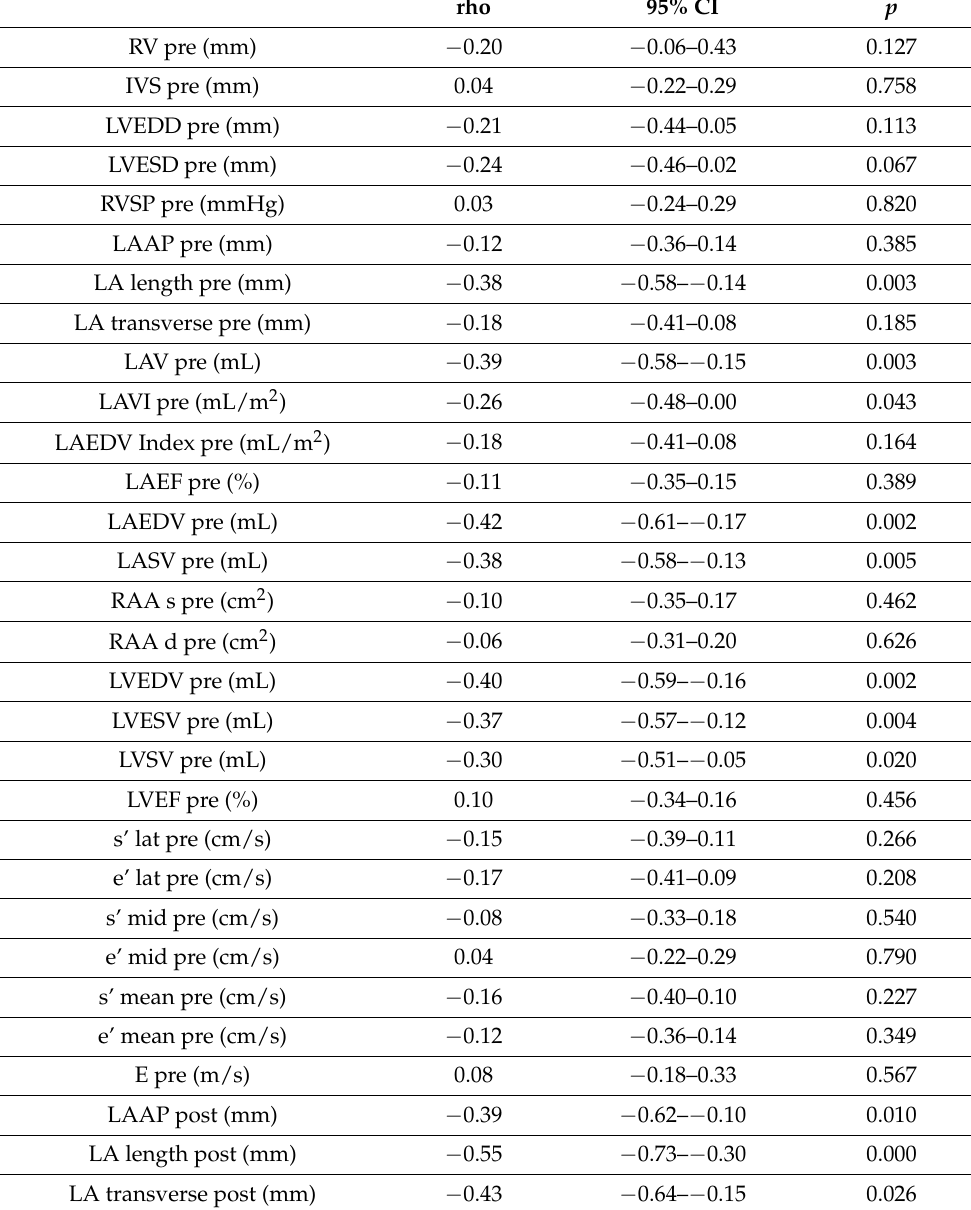
Table 3. Correlations of galectin-3 concentration with the assessed echocardiographic